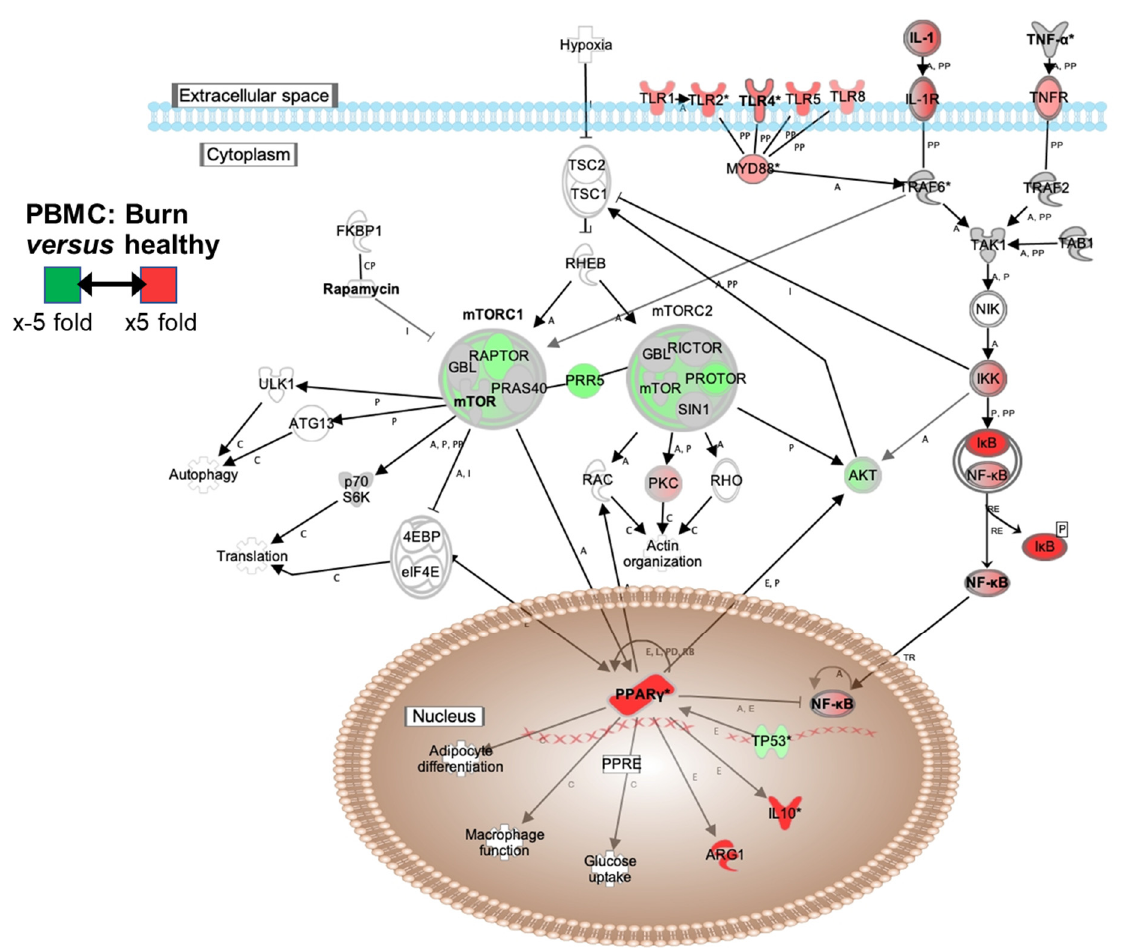
Figure 7. Burn injury induces significant alterations in peripheral immunometabolic canonical immune and metabolic signaling pathways compared to healthy controls. mRNA was isolated from PBMC, which was isolated from burn patients or healthy controls, and gene expression was evaluated using nanostring barcoding (nCounter Human Immune Profiling PanCancer CodeSet; 770 genes, and the Human Metabolic Gene CodeSet; 768 genes). Fold changes were generated utilizing nSolver v4.0 and R, and significantly altered ( p < 0.05) gene expression data versus healthy controls were plotted on a canonical pathway schematic for specific mTOR, TLR, and NF κ B pathways.